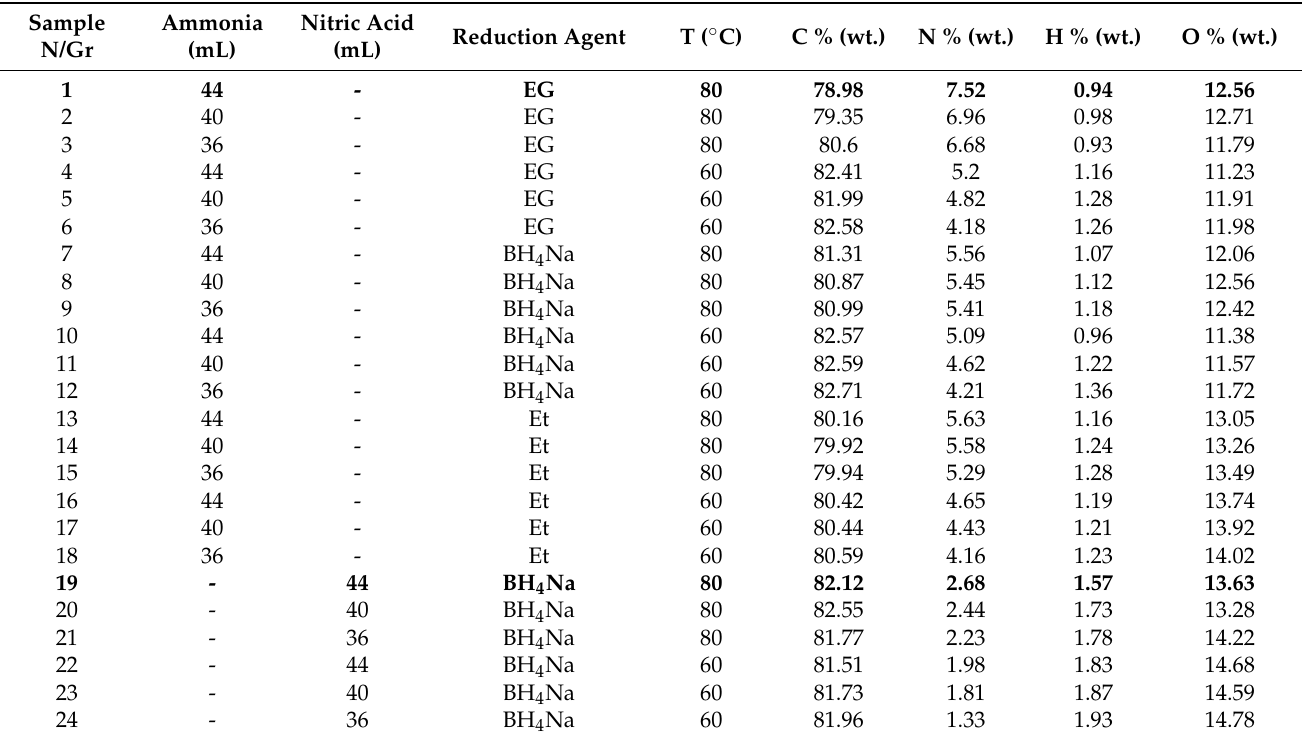
Table 1. Nitrogen-doped graphene oxide obtained by using the microwave method; comparison of N doping ratio based on experimental condition (inorganic N precursors: ammonia and nitric